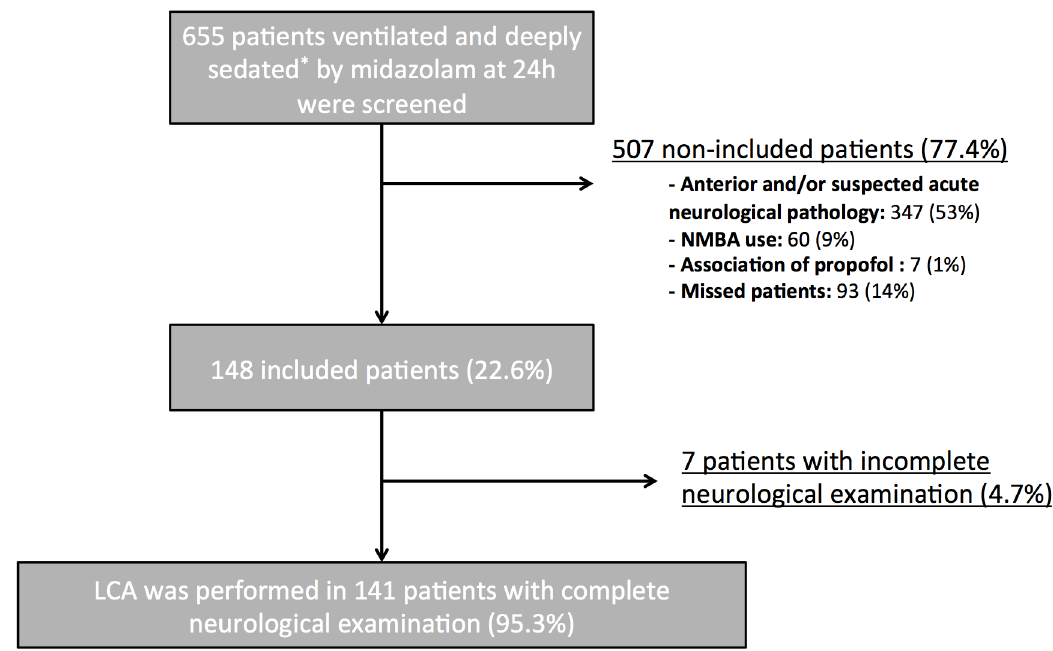
Fig 1. Flow chart. NMBA: neuromuscular-blocking agent; RASS: RichmondAssessment SedationScale.